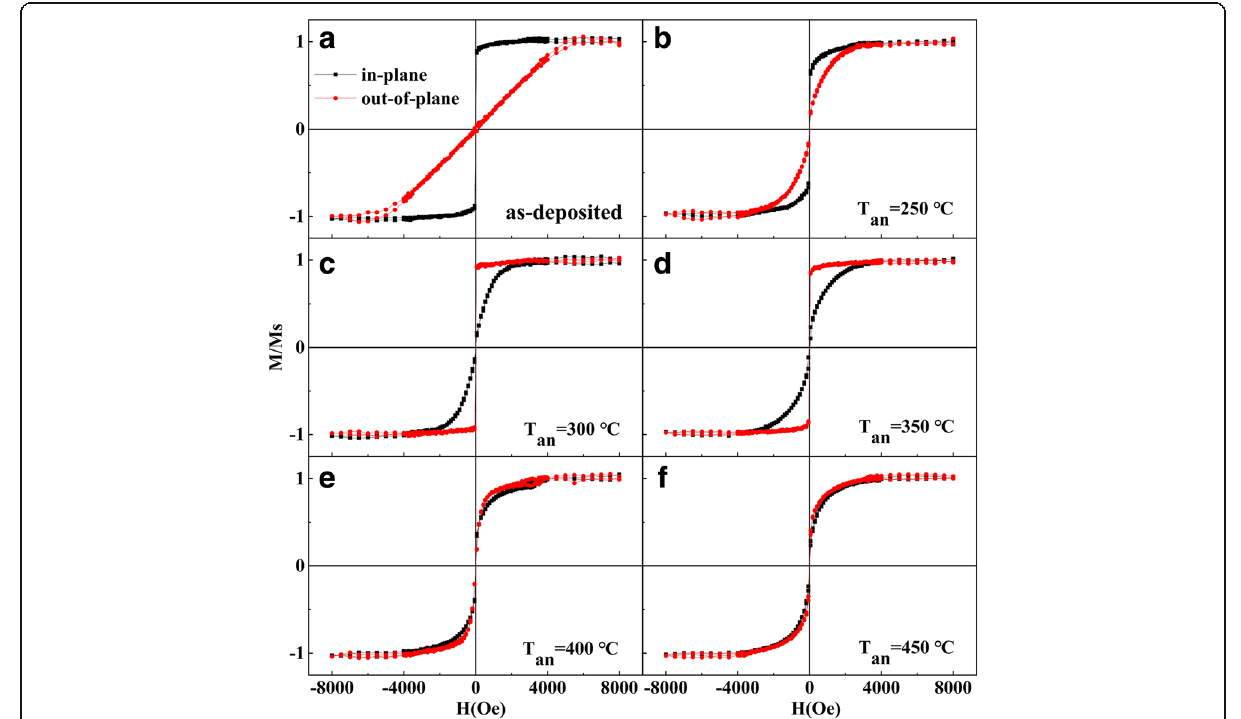
Fig. 2 In-plane and out-of-plane M-H loops of the Ta/Pd/CFMS (2.3 nm)/MgO (1.3 nm)/Pd films annealed at different temperatures. a As-deposited. b 250 ° C. c 300 °C. d 350 °C. e 400 °C. f 450